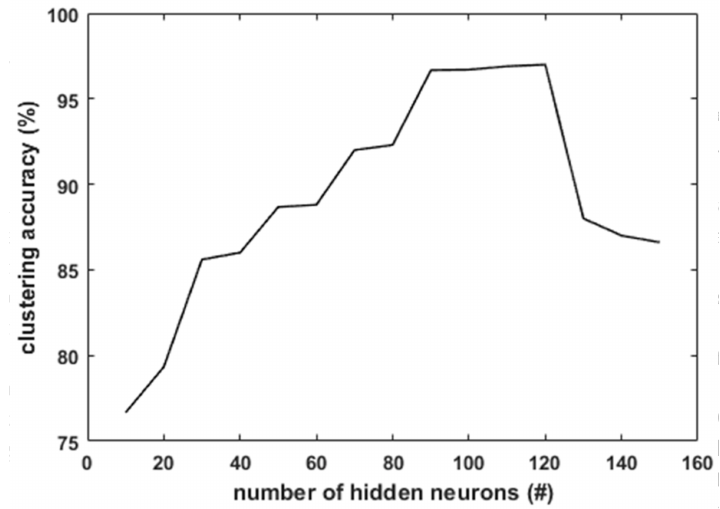
Figure 5. Clustering accuracy versus number of hidden neurons.